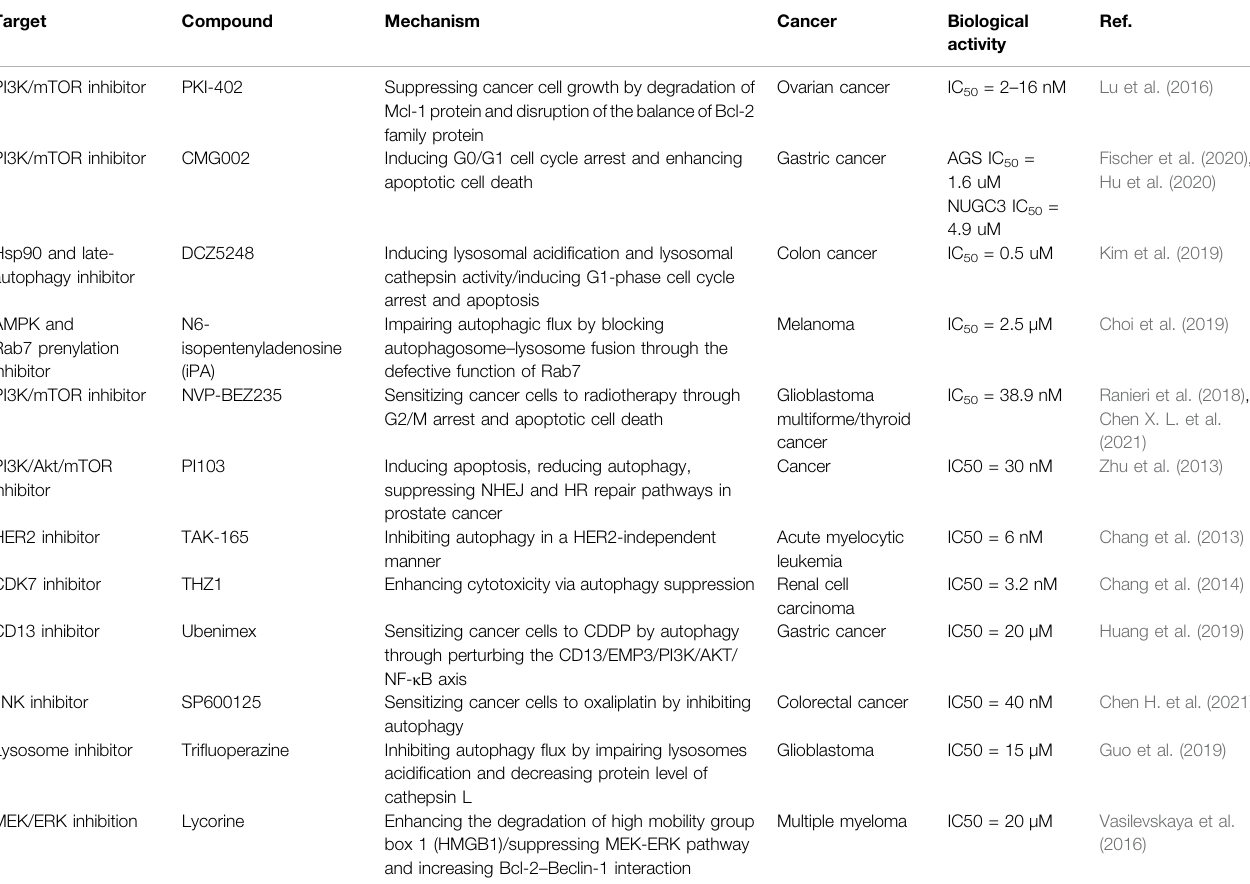
TABLE 3 | Dual and multiple targeted small-molecule compounds for inhibiting autophagy in